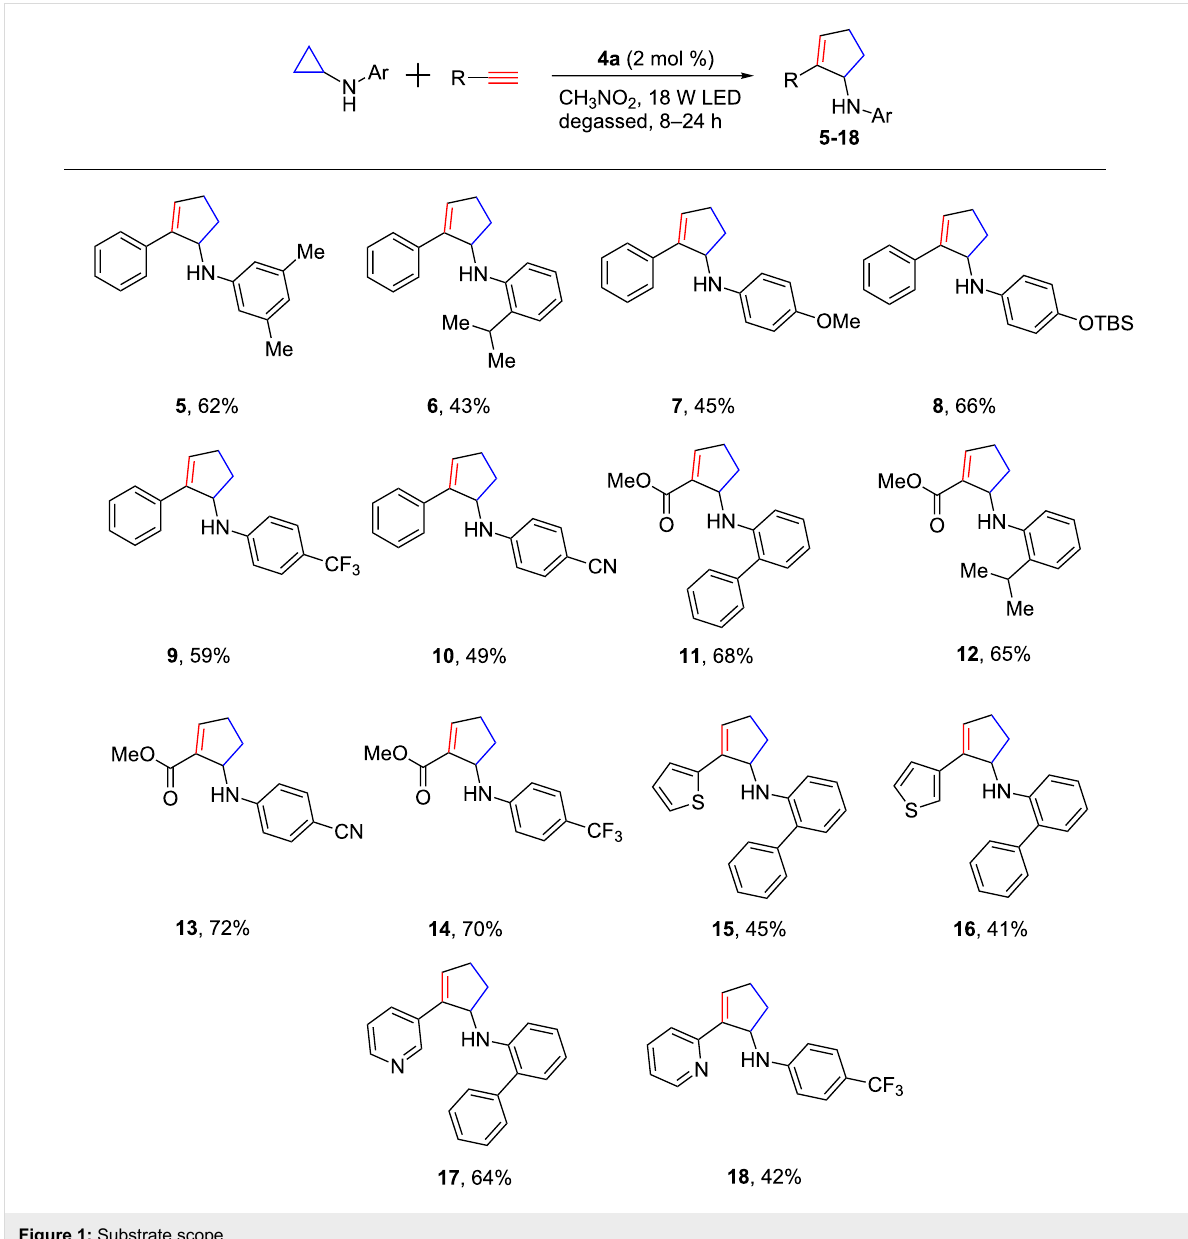
Figure 1: Substrate